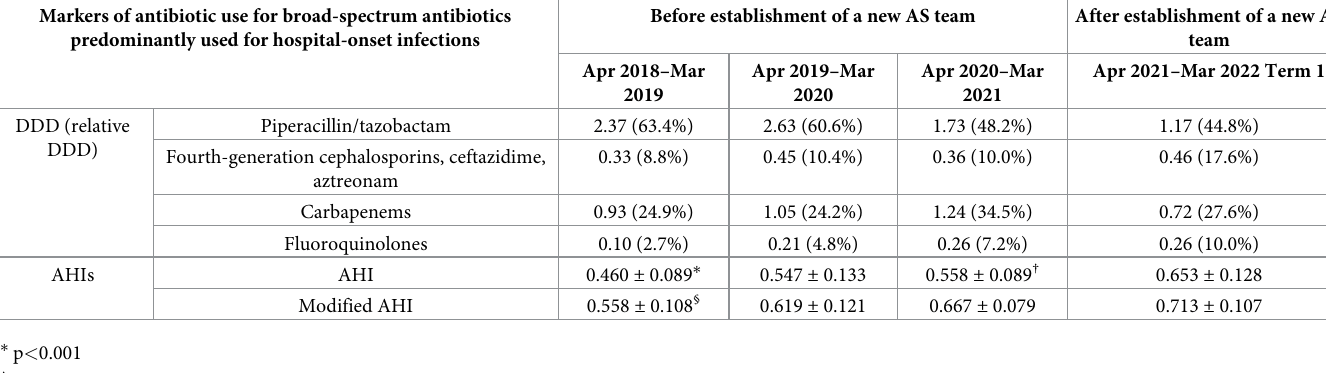
Table 4. Defined daily dose (DDD) of each broad-spectrum antibiotic commonly used for hospital-onset infections and the antibiotic heterogeneity indices (AHIs) before and after establishment of a new antimicrobial stewardship (AS) team in the community hospital. Markers of antibiotic use for broad-spectrum antibiotics Before establishment of a new AS team After establishment of a new AS predominantly used for hospital-onset infections